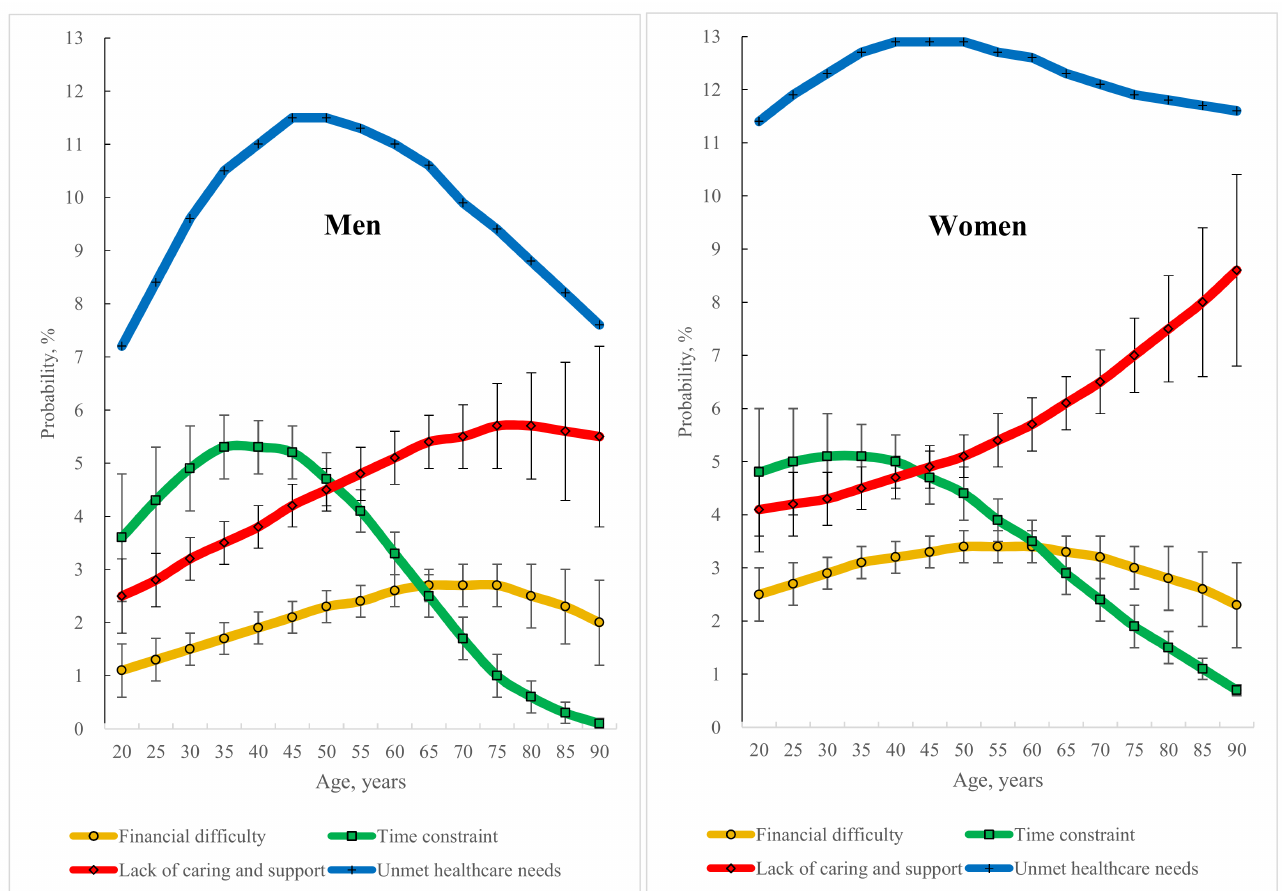
Figure 2. Change in the average adjusted probability (and its 95% confidence interval) of people’s experience of a type of barrier that leads to unmet healthcare needs across different age groups by gender. Source: The Korea Health Panel survey data